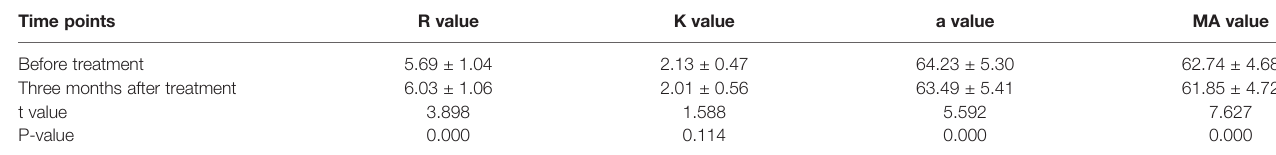
TABLE 3 | Comparison of TEG parameters three months after treatment and before treatment in the observational group (mean ± standard deviation). Time points R value